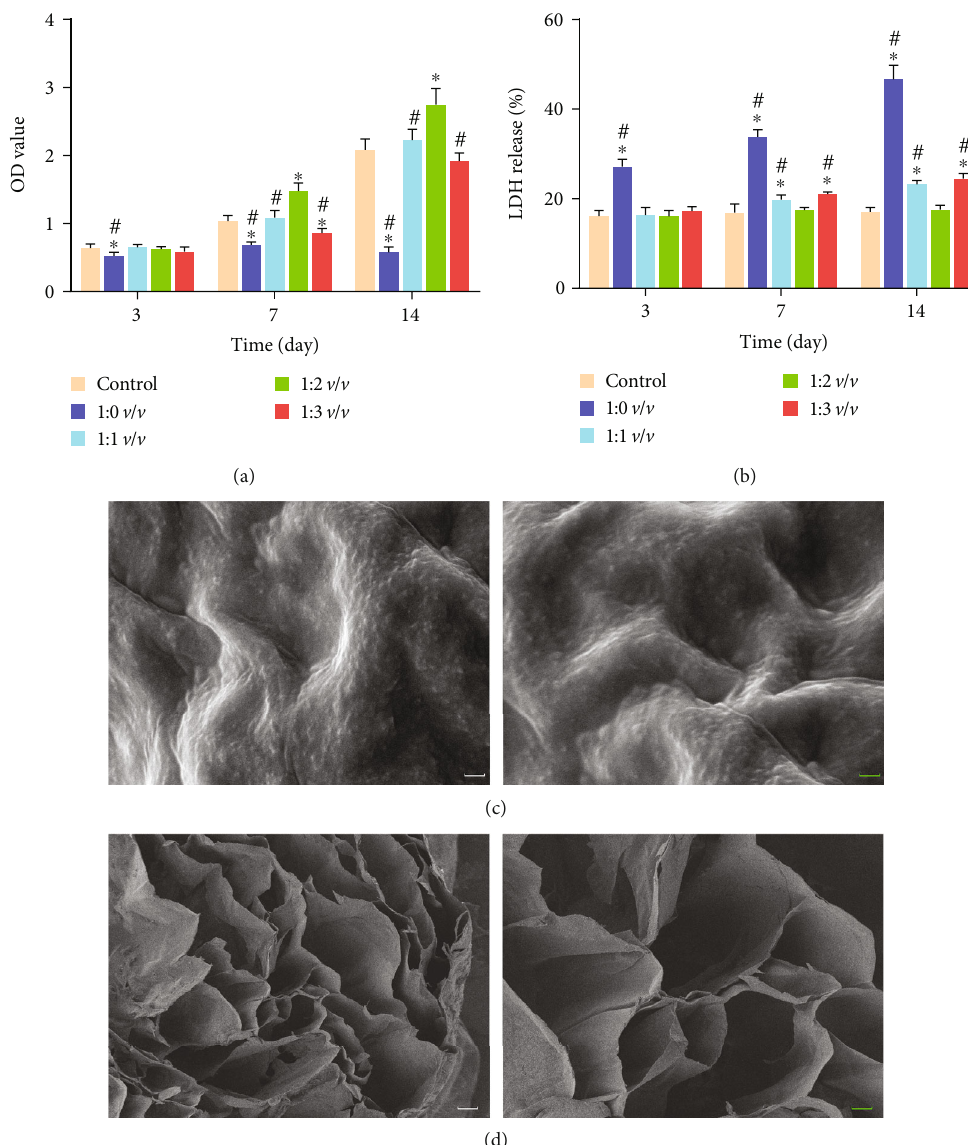
Figure 3: The proper concentration of hydrogel and microstructure of the hydrogel. (a) The proliferation of NPMSC cultured in di ff erent concentrations of hydrogels. (b) The cytotoxicity of di ff erent concentrations of hydrogel for NPMSC. (c) SEM image of the 1: 2 v / v hydrogel surface. (d) Cross sections of 1:2 v / v hydrogel. Data represent mean ± SD ; the error bars represent the standard deviation of measurements for 6 separate samples ( n = 6 ); ∗ p < 0 : 05 compared with control group; # p < 0 : 05 compared with 1 :2 v / v group. White scale bar = 100 μ m , blue scale bar = 50 μ m